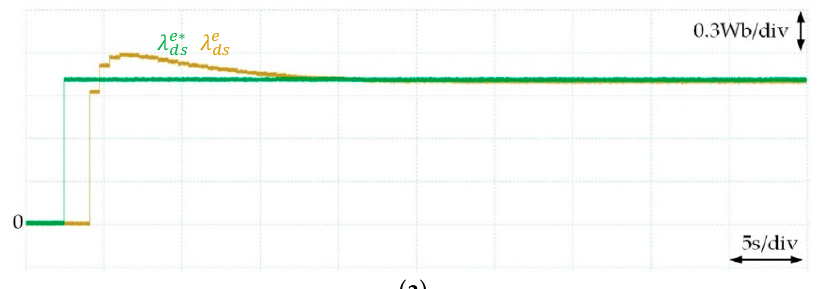
1 in Table 1 and estimated stator flux ( 𝜆 (cid:3031)(cid:3046)(cid:3032) ) in the proposed stator inductance identification